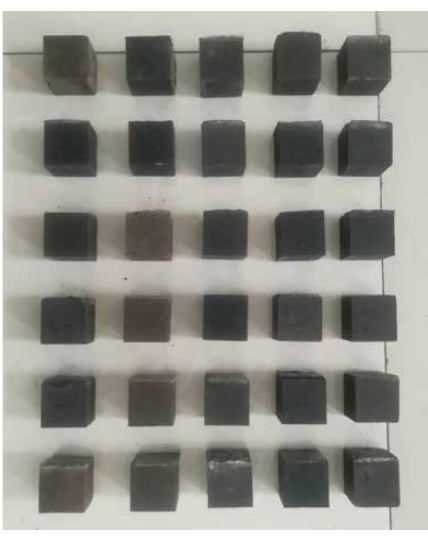
Figure 7: Specimens for compressive strength test.